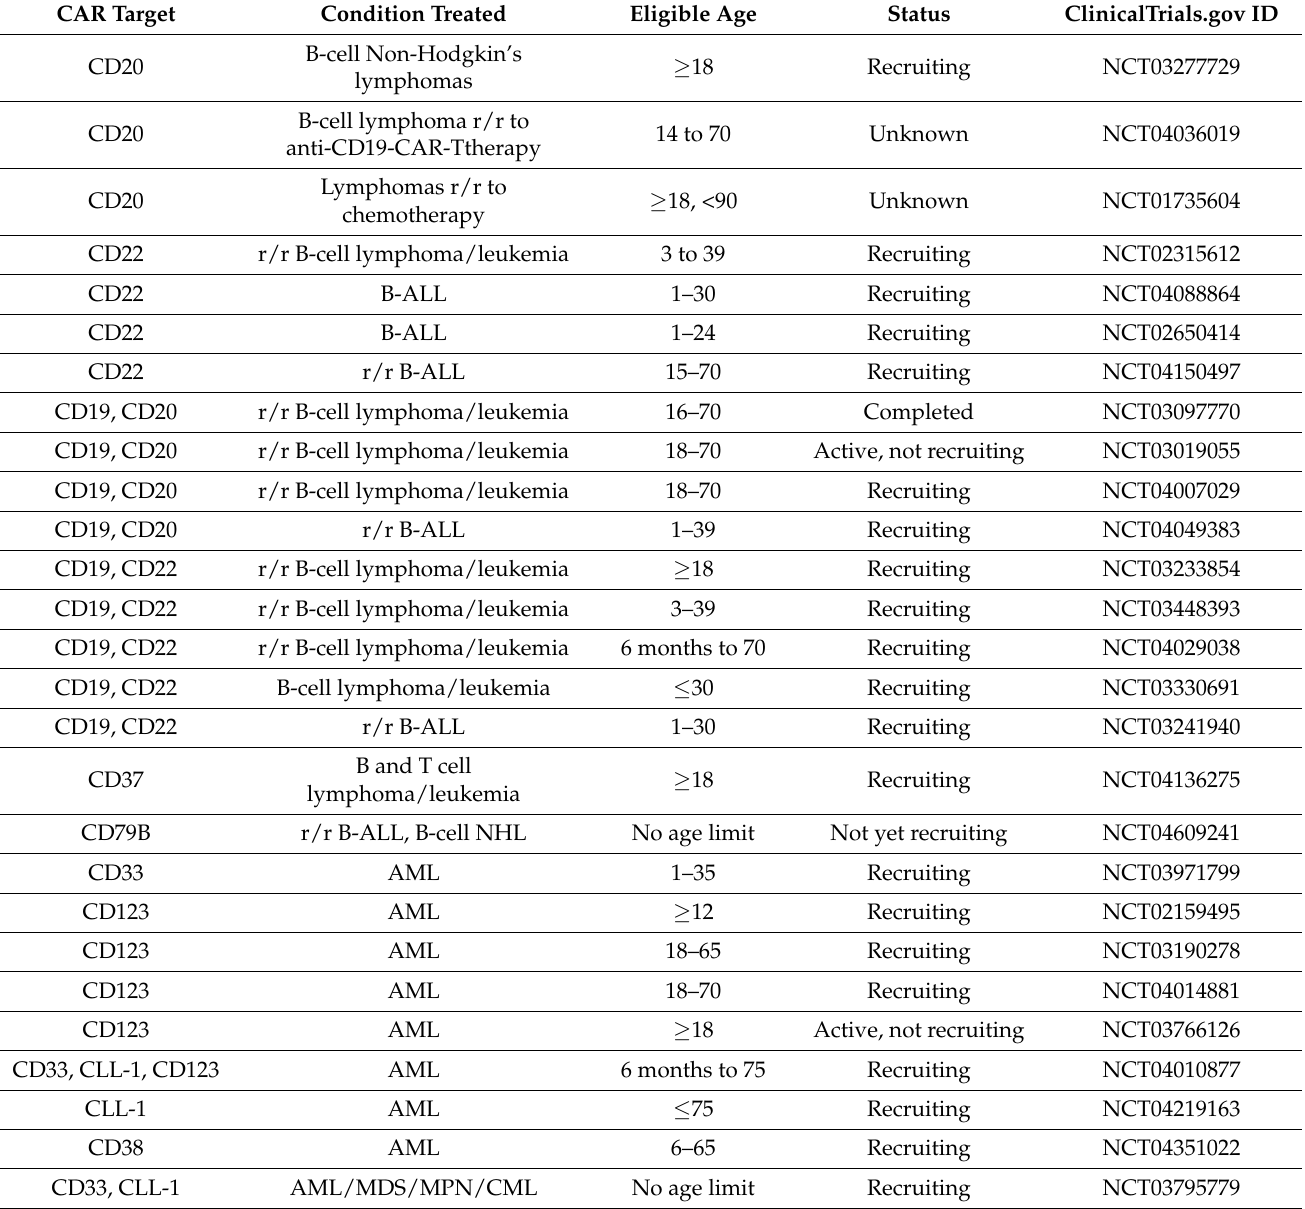
Table 2. CAR T cell trials for B-lymphoid leukemias (non-CD19 targeting) and